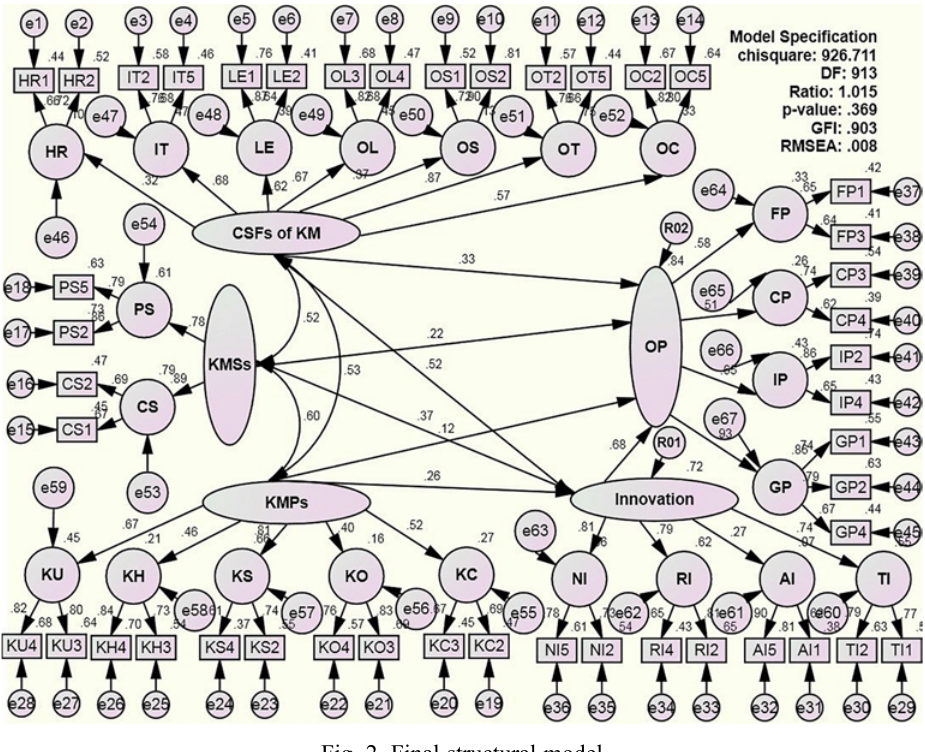
Fig. 2. Final structural Table 2. Direct relationships in final structural model